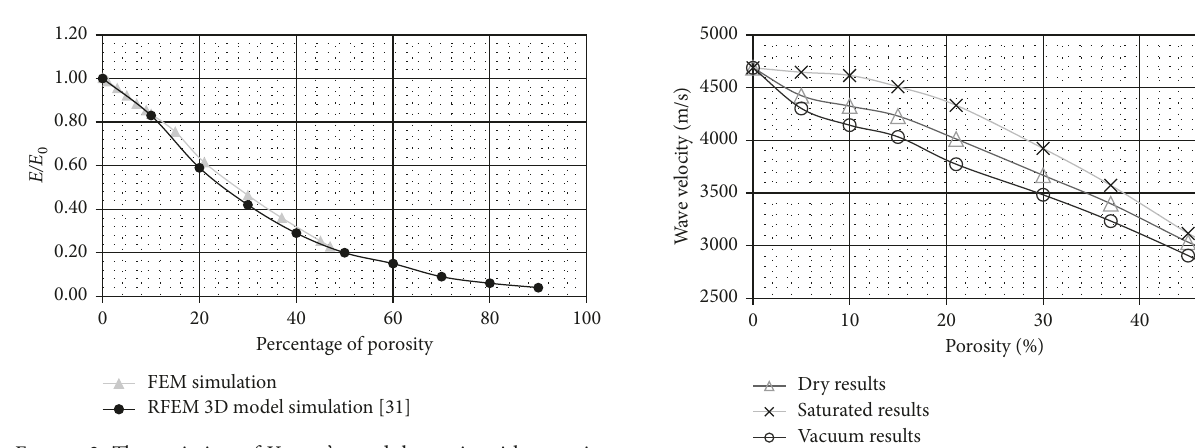
Figure 2: The variation of Young’s modulus ratio with porosity.